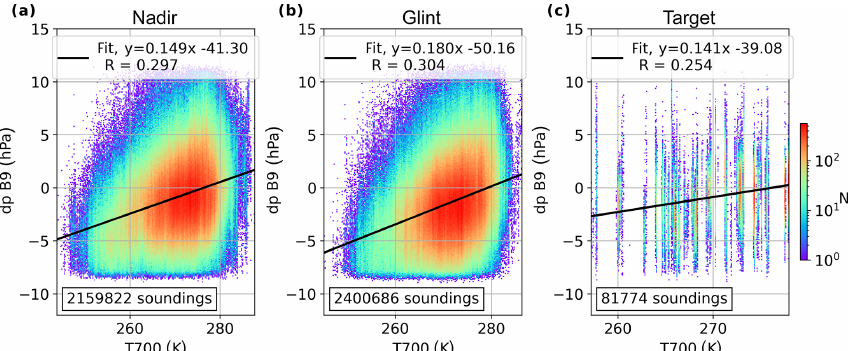
Figure 13. Correlations and linear regressions for the difference between retrieved and a priori surface pressure from GEOS5 forward processing for instrument teams (GEOS5-FP-IT; dp) as a function of temperature at 700hPa (T700) for all retrievals over land north of 50 ◦ N that pass boreal QC and separated here by viewing geometry.